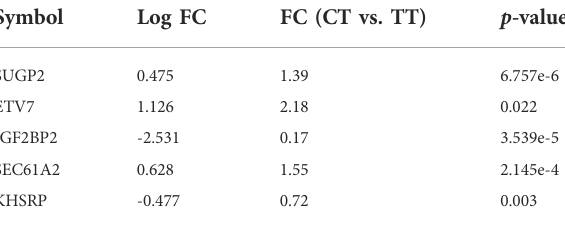
TABLE 5 Fold changes (FC) and p values for the fi ve genes found to be differentially expressed and differentially occupied by SIRT6 in iPSC-neurons from people with FRDA with the CT SIRT6 genotype vs. the TT SIRT6 genotype.